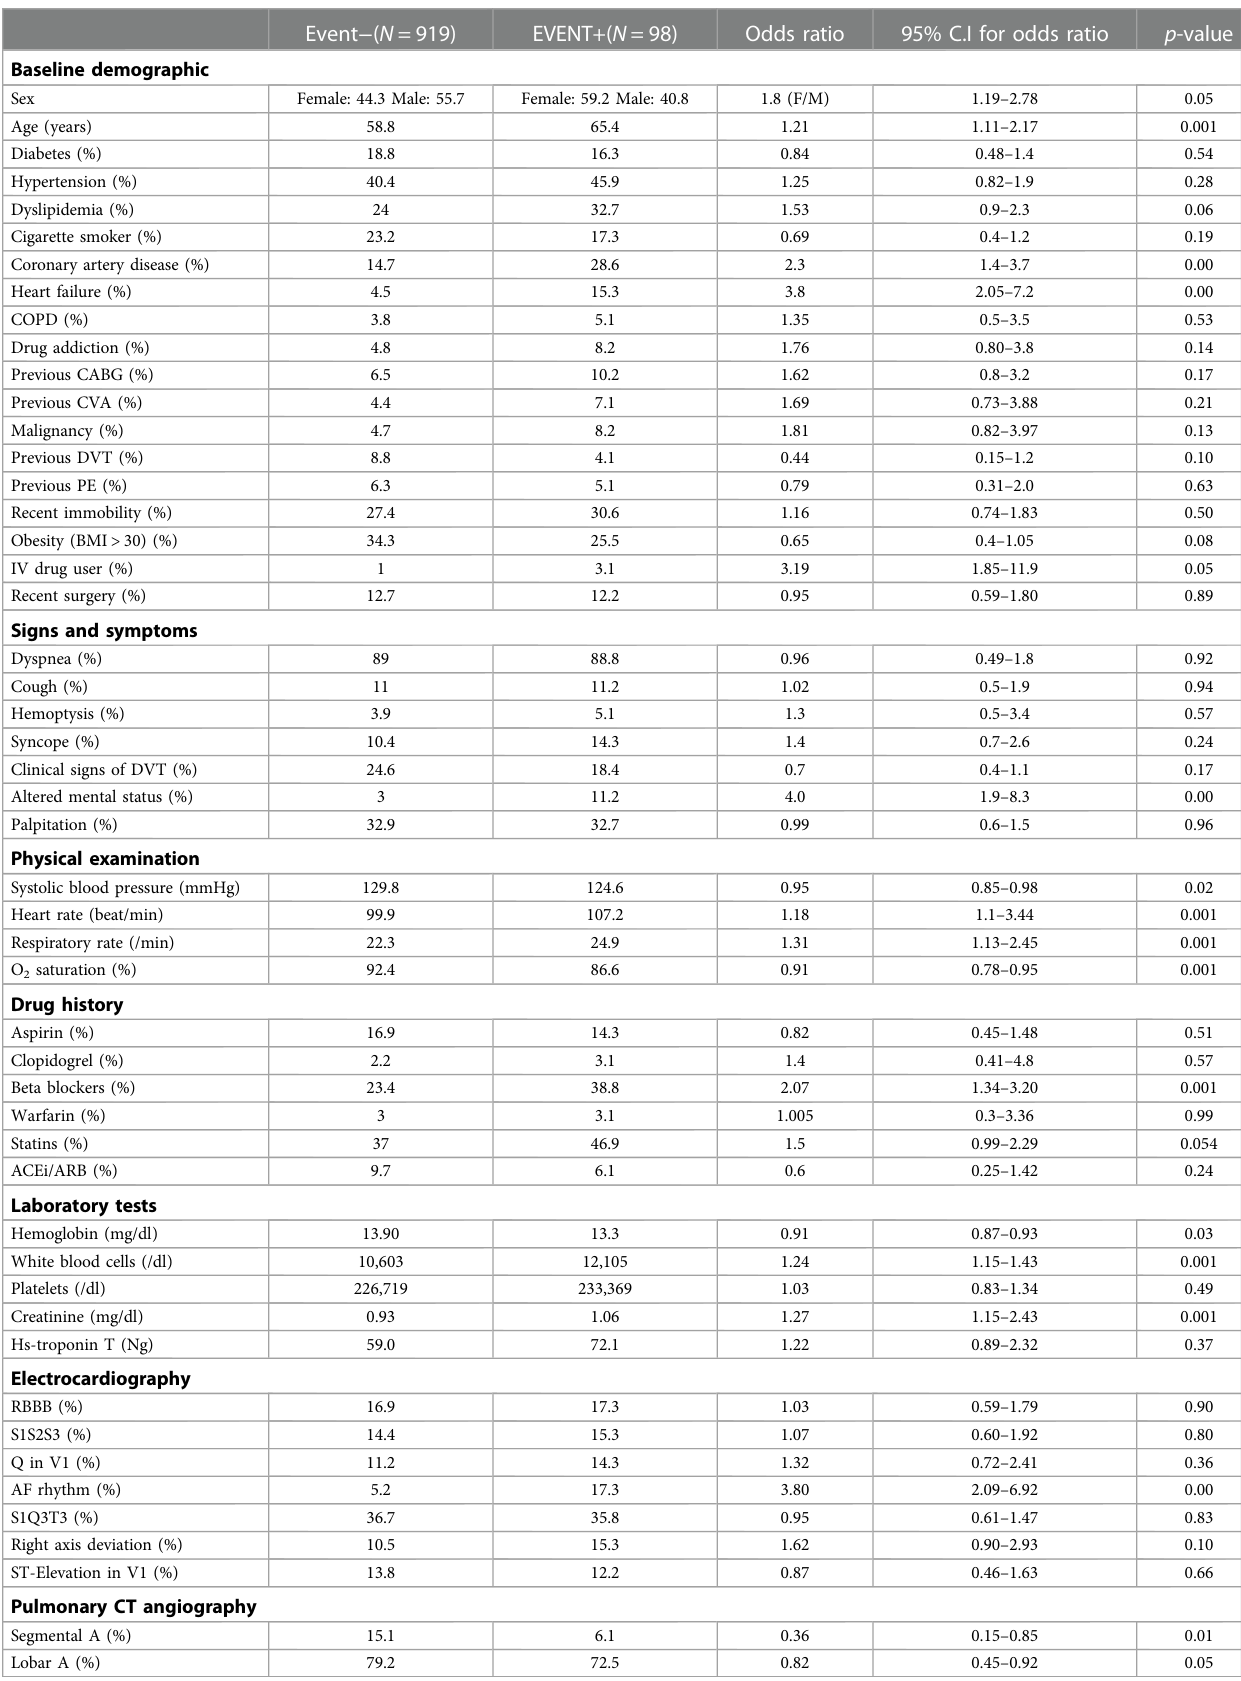
TABLE 1 Intergroup comparison of baseline